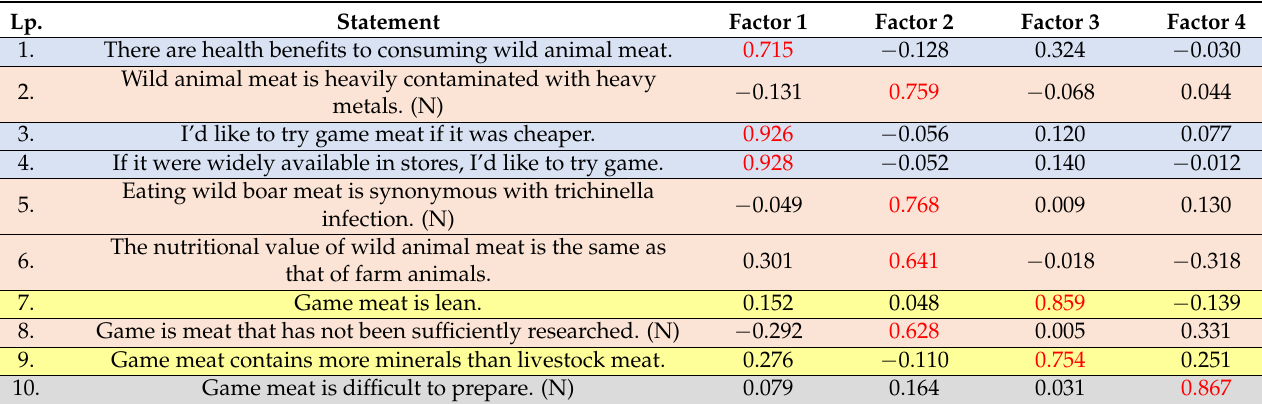
Table 3. Factor charges after the varimax rotation.